Question: Name the type of graph shown.
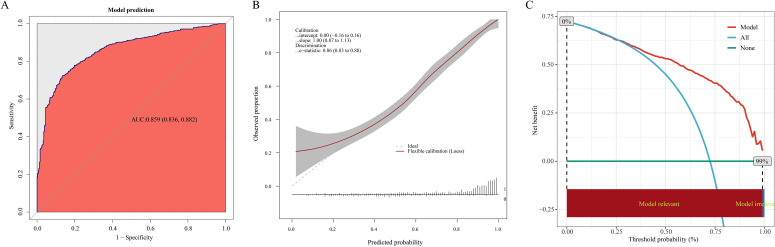
Answer: line